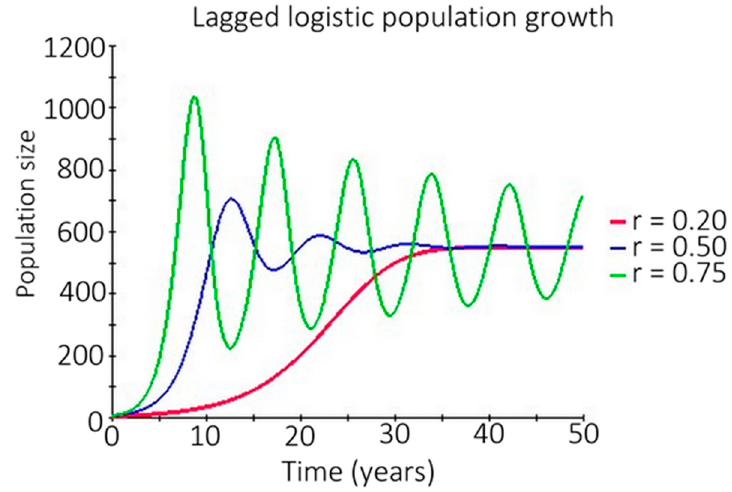
Figure 13. Population growth trajectories under the lagged logistic population growth model with a lag period τ = 2 years, initial population of 5 plants, at three intrinsic growth rates (r) 0.2, 0.5, and 0.75, and carrying capacity K = 550. The population growth curve was smooth with r = 0.2, and the carrying capacity was reached after 35 years. With r = 0.5, the population growth was a damped oscillation that stabilised only after 35 years. With r = 0.75, the population size oscillated perpetually. Scenario 2. A run of years of drought causes a contraction of carrying capacity.